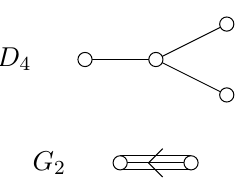
Figure 4 . Dynkin diagram D 4 (Lie algebra so (8) ) has a triality S 3 outer automorphism which permutates its three branches. Folding it by average yields the Dynkin diagram G